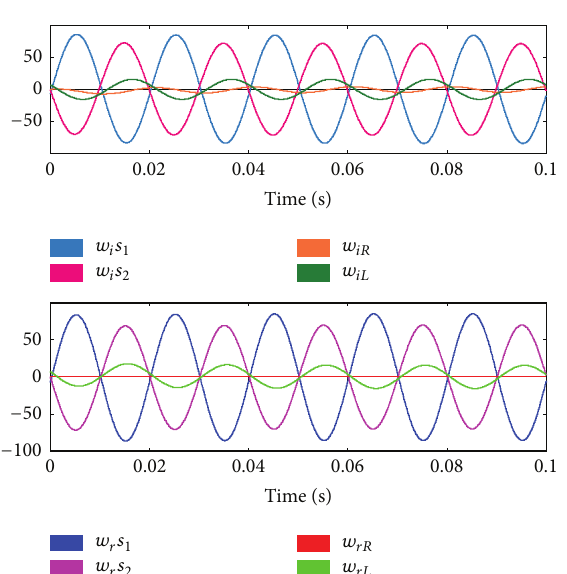
Figure 16: Power waves for the StBG of Figure 15.